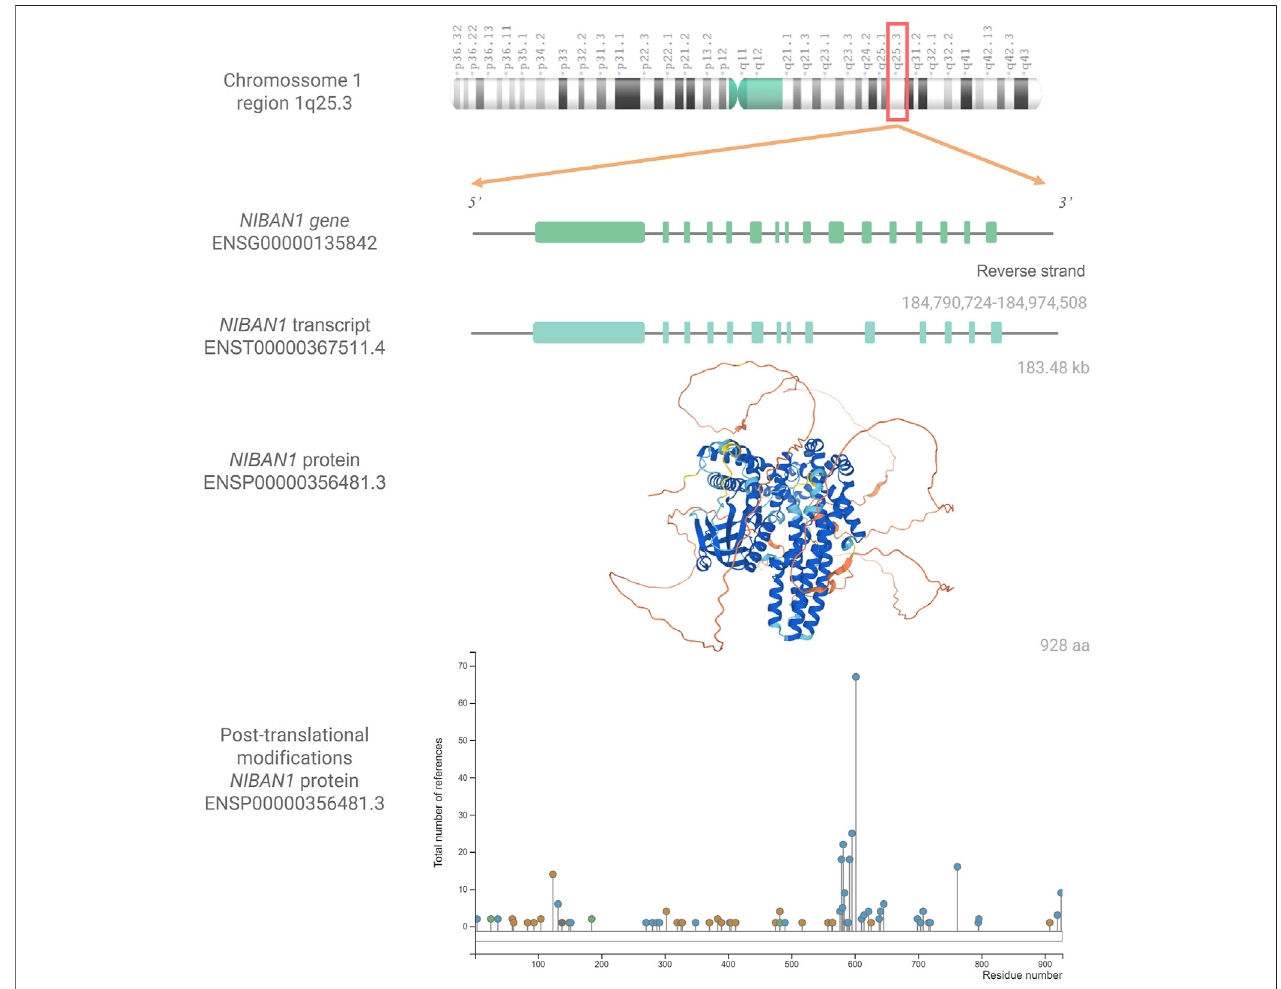
FIGURE 1 | NIBAN1 : gene, transcript, protein and post-tranlational modi fi cations. Chromosome 1q25.3 showing the NIBAN1 gene (ENSG00000135842) in the region 184,790,724-184,974,580, with its 16 exons, followed by the transcribed variant ENST00000367511.4 with 14 exons (Ensembl Genome Browser, GRCh38.p13) as well as the three-dimensional predicted NIBAN1 protein structure (ENSP00000356481.3). Structuring cores indicate the degree of reliability of the prediction.DarkBlue=VeryHigh,LightBlue=Con fi dent,Yellow=Low,andOrange=VeryLow.ImageavailablefromAlphaFold,https://alphafold.ebi.ac.uk/entry/ Q9BZQ8 (version: 2.1.0) (Jumper et al., 2021; Varadi et al., 2022). Graph representing the post-translational modi fi cations in the respective residues of the NIBAN1 (ENSP00000356481.3).Phosphorylation marksarerepresentedbyblue circles; acetylation,bygreencircles; ubiquitination, byorangecircles, andothertypes ofmarks by gray circles. Image available from PhosphoSitePlus ® , https://www.phosphosite.org/uniprotAccAction?id=Q9BZQ8 (version: 6.5.9.3) (Hornbeck et al., 2015).